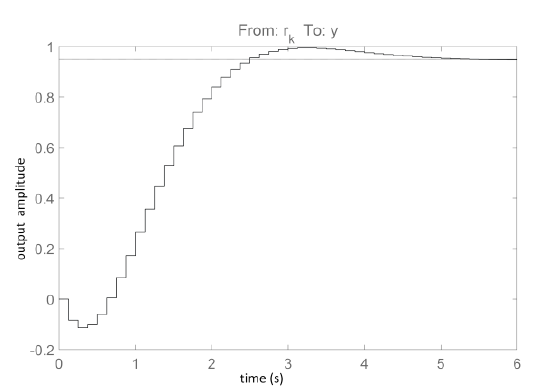
Figure 4. Step response of the OE identified model [31].